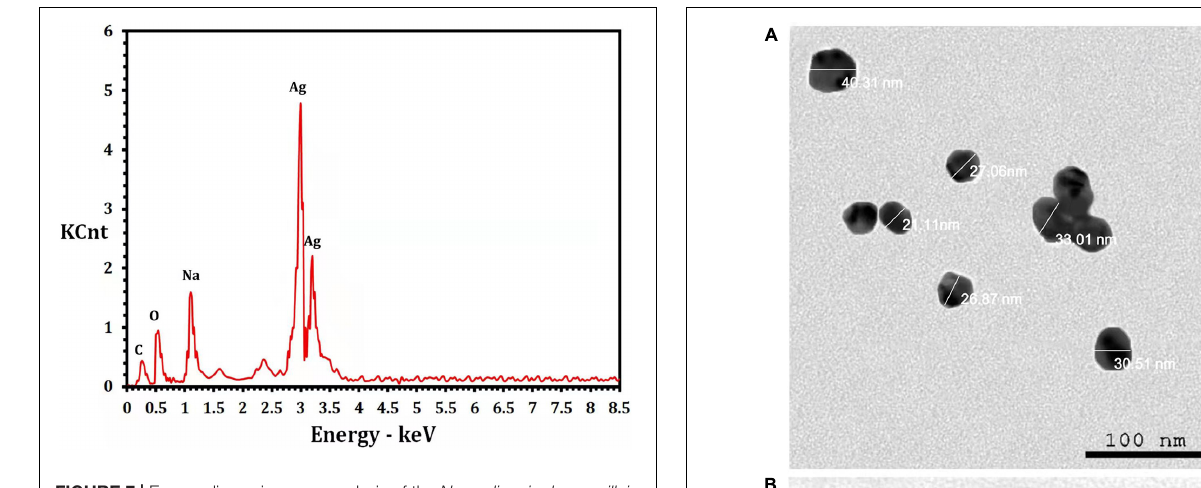
Frontiers in Microbiology |